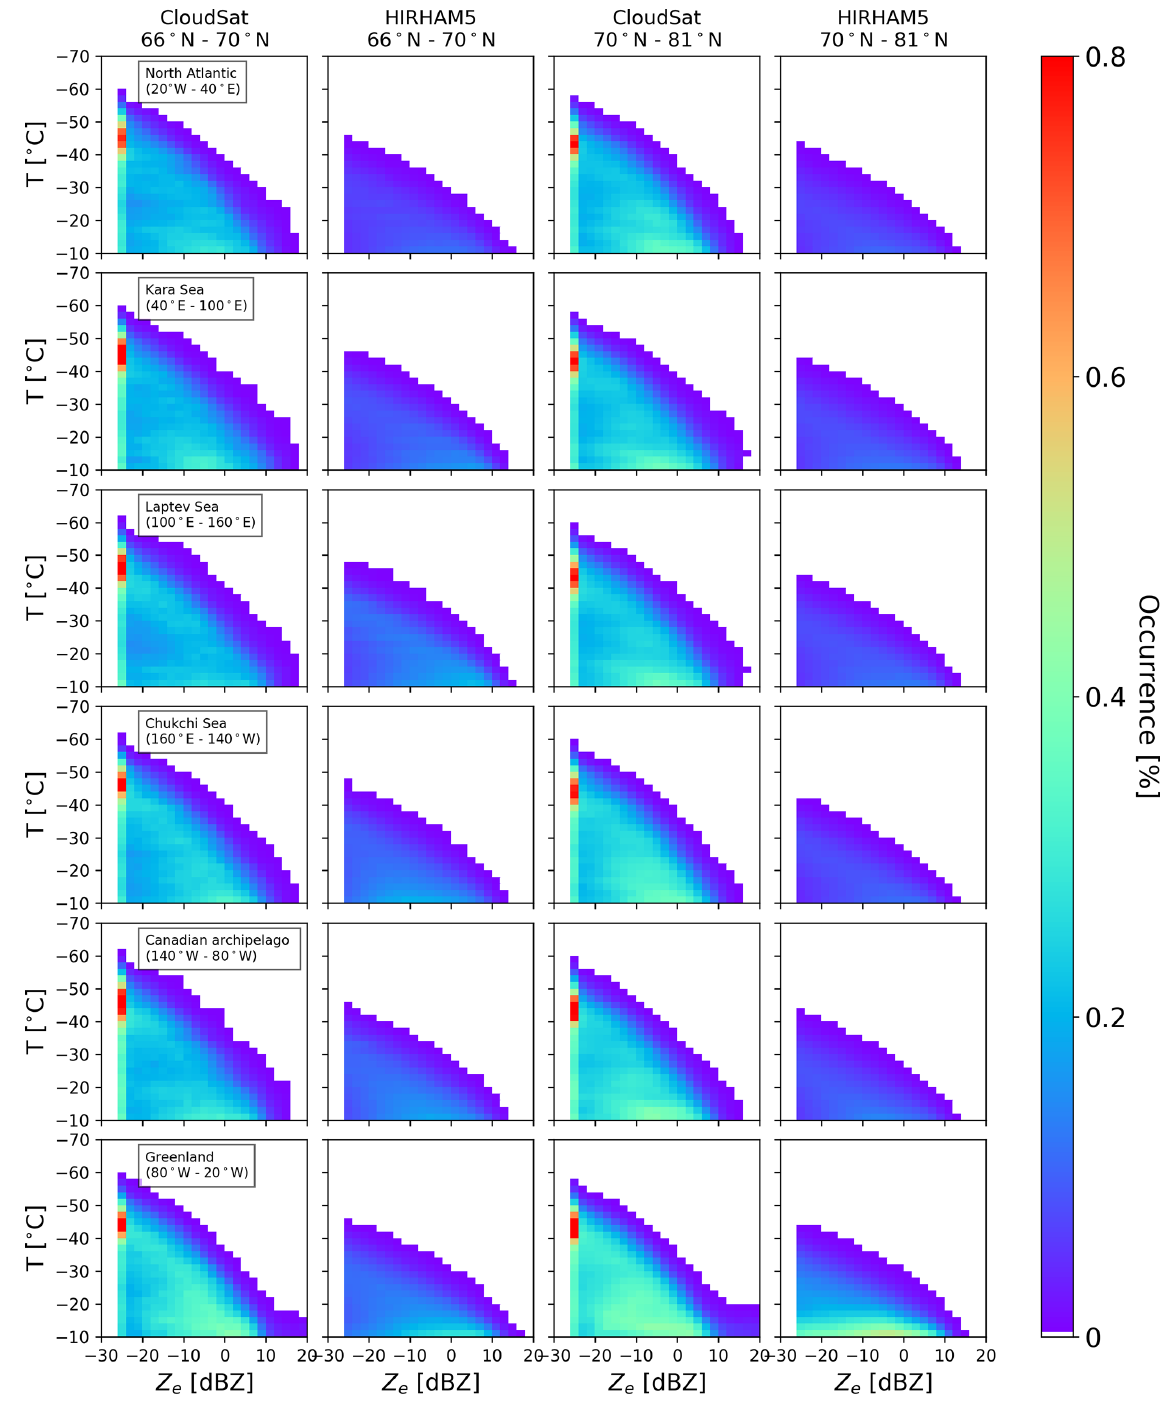
Figure A8. The observed and modeled CFTDs for both latitude band regions in the summer season (JJA, 2007–2010). On the x axis is the reflectivity in dBZ, and on the y axis is the temperature from − 70 to − 10 ◦ C. The normalization is done by the sum of total